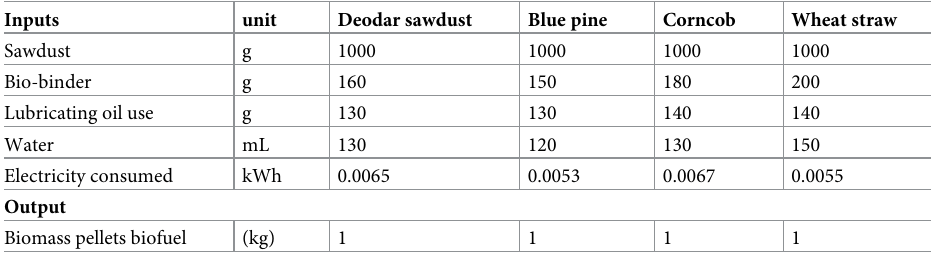
Table 1. LCI for biomass pellets biofuel production from agroforest residues in Gilgit-Baltistan, Pakistan. Inputs unit Deodar sawdust Blue pine Corncob Wheat straw Sawdust g 1000 1000 1000 1000 Bio-binder g 160 150 180 200 Lubricating oil use g 130 130 140 140 Water mL 130 130 150 Electricity consumed kWh 0.0065 0.0053 0.0067 0.0055 Output Biomass pellets biofuel (kg) 1 1 1